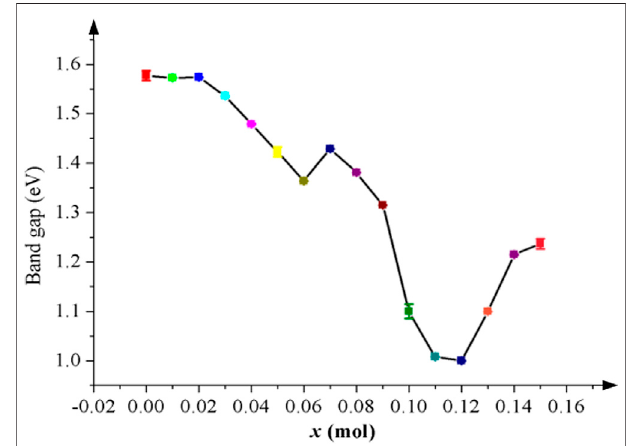
FIGURE 2 | The band gap of Li 1.2 − x Na x Mn 0.54 Ni 0.13 Co 0.13 O 2 becomes narrower after sodium doping, which means its conductivity is improved notably. The error bars show that the accuracy of our band gap values is